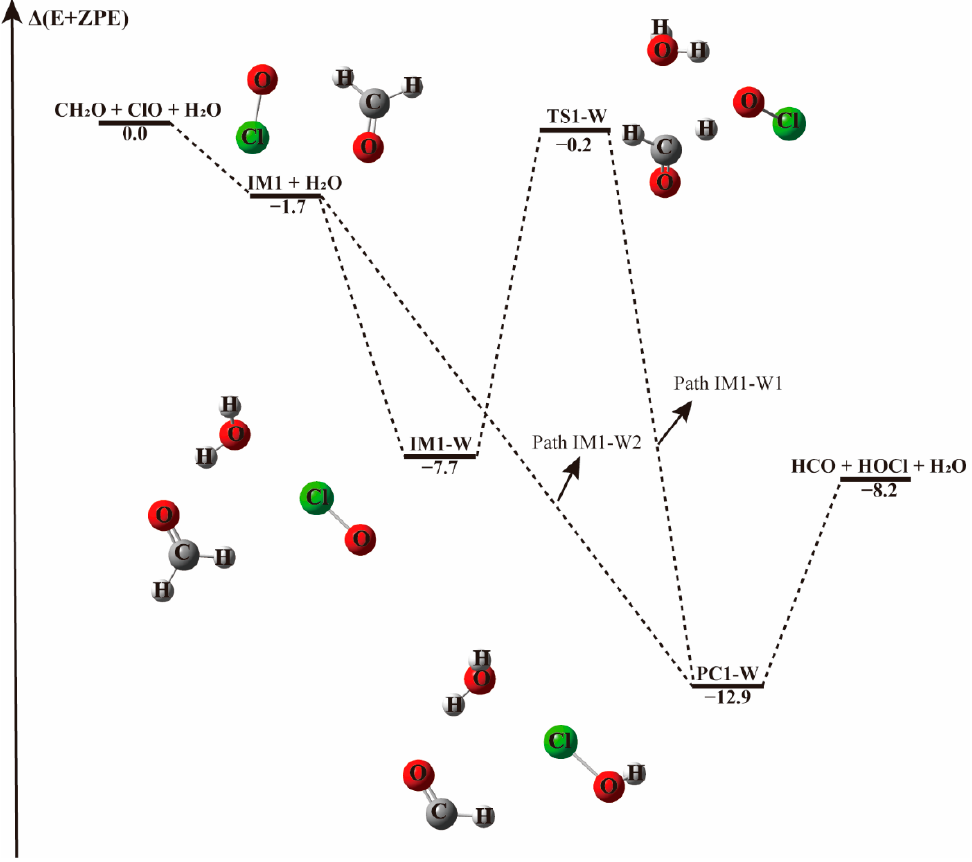
Figure 2. The energy profile of the CH 2 O + ClO water-free reaction occurring through the IM1 + H 2 O pathway. Energies (in kcal mol − 1 ) are calculated at the CCSD(T)/aug-cc-pVTZ//B3LYP-D3/aug-cc-pVTZ level.